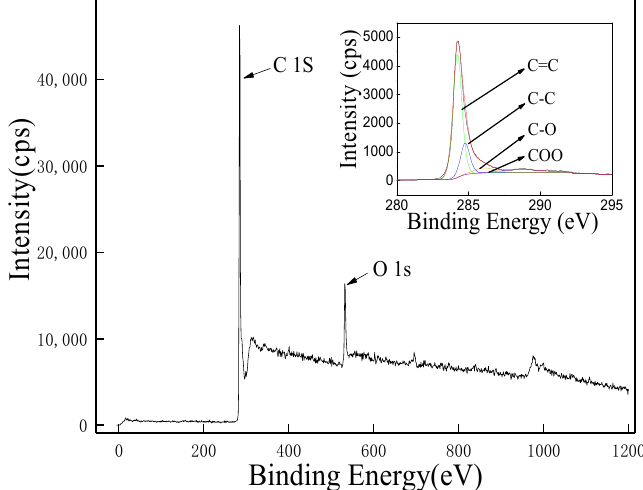
Figure 3. XPS spectra for PABA-modified MWCNTs. The inset shows the C1s spectra of modified MWCNTs.